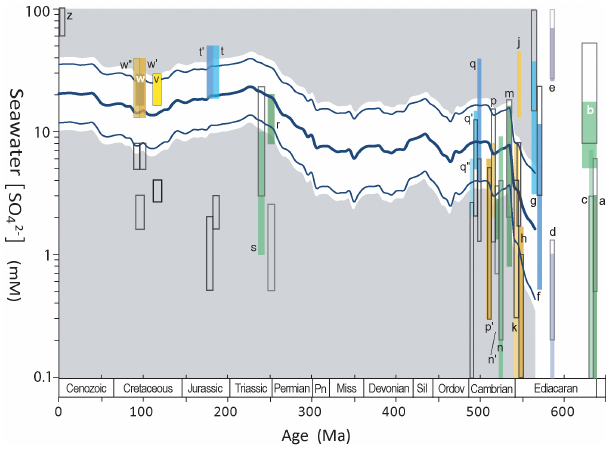
Figure 10. Seawater sulfate concentrations for late Neoproterozoic and Phanerozoic marine units (Figs. 6–8) compared with long-term [SO 2 − ] SW curve (Fig. 4). Estimates of [SO 2 − ] SW are based on (1) 4 4 the rate method (calculated as per Eqs. 3 and 4; shown as open boxes) and (2) the MSR-trend method (calculated as per Eqs. 6–8; shown as solid boxes); note that unit symbols and colors are keyed to Table S4 and Figs. 6–8. See text for discussion. Other details as in Fig.